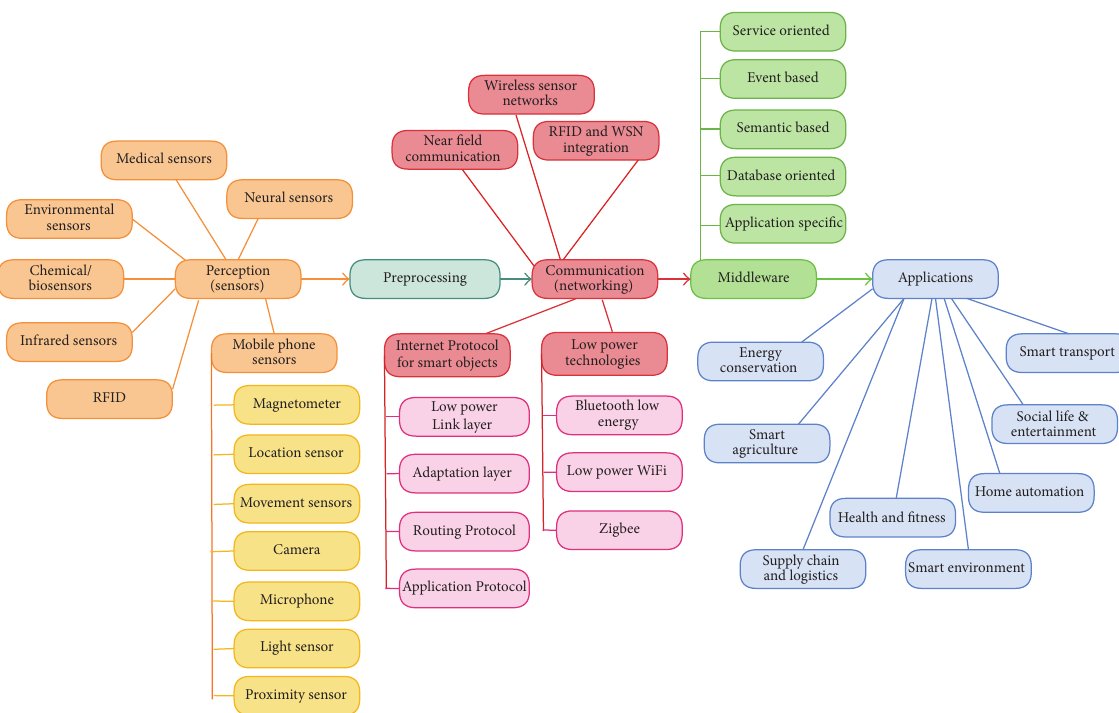
Figure 3: Taxonomy of research in IoT